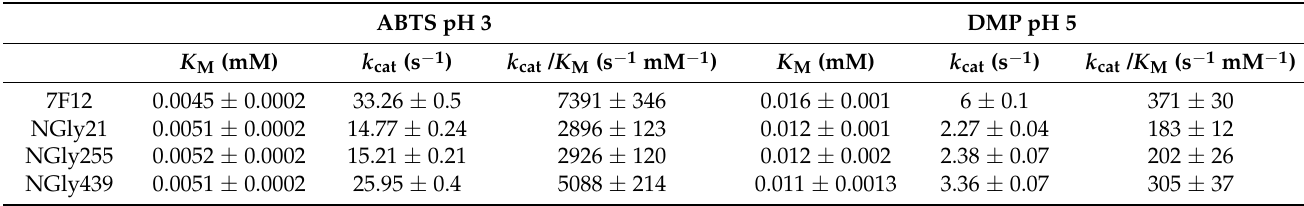
Table 8. Kinetic constants of 7F12 laccase and its NGly